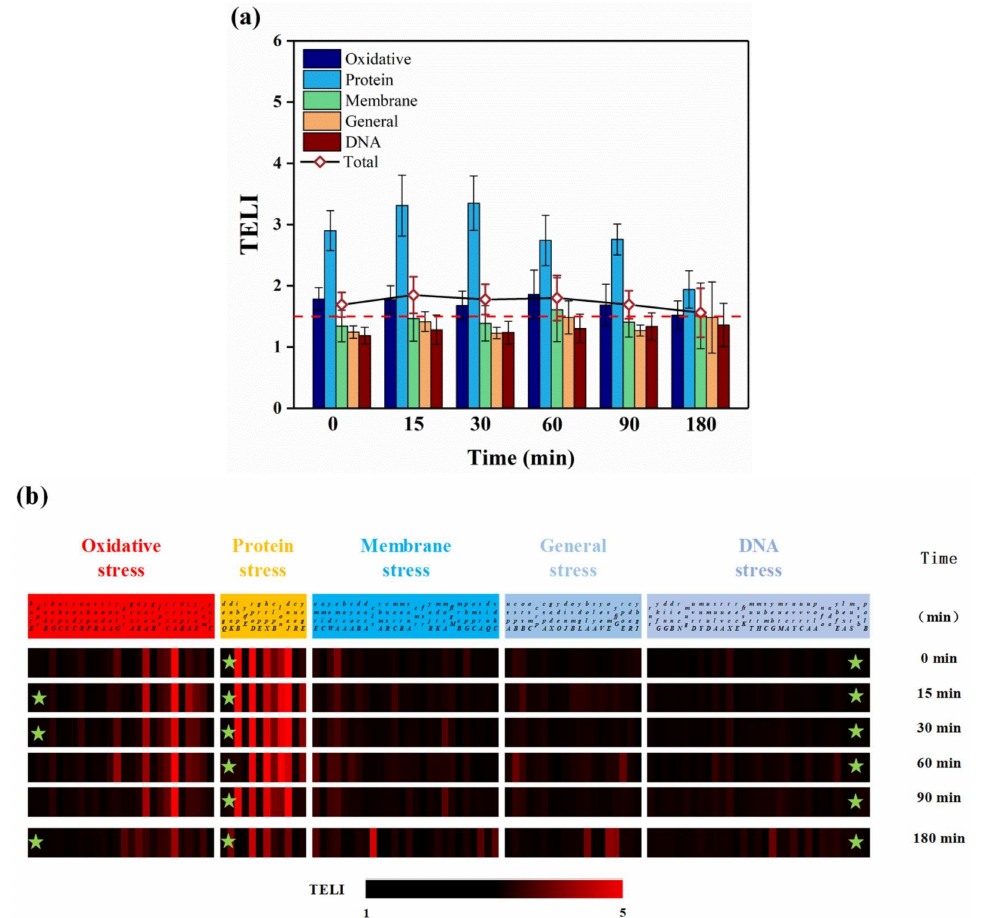
Figure 3. ( a ) The TELI-based toxicity profile changes during the electrochemical oxidation of HMX. ( a ) The TELI values for the 5 stress response categories and total TELI; ( b ) the TELI values for genes. The green star ( (cid:70) ) indicates the significantly affected ( p < 0.05) stress response categories revealed by the gene set enrichment